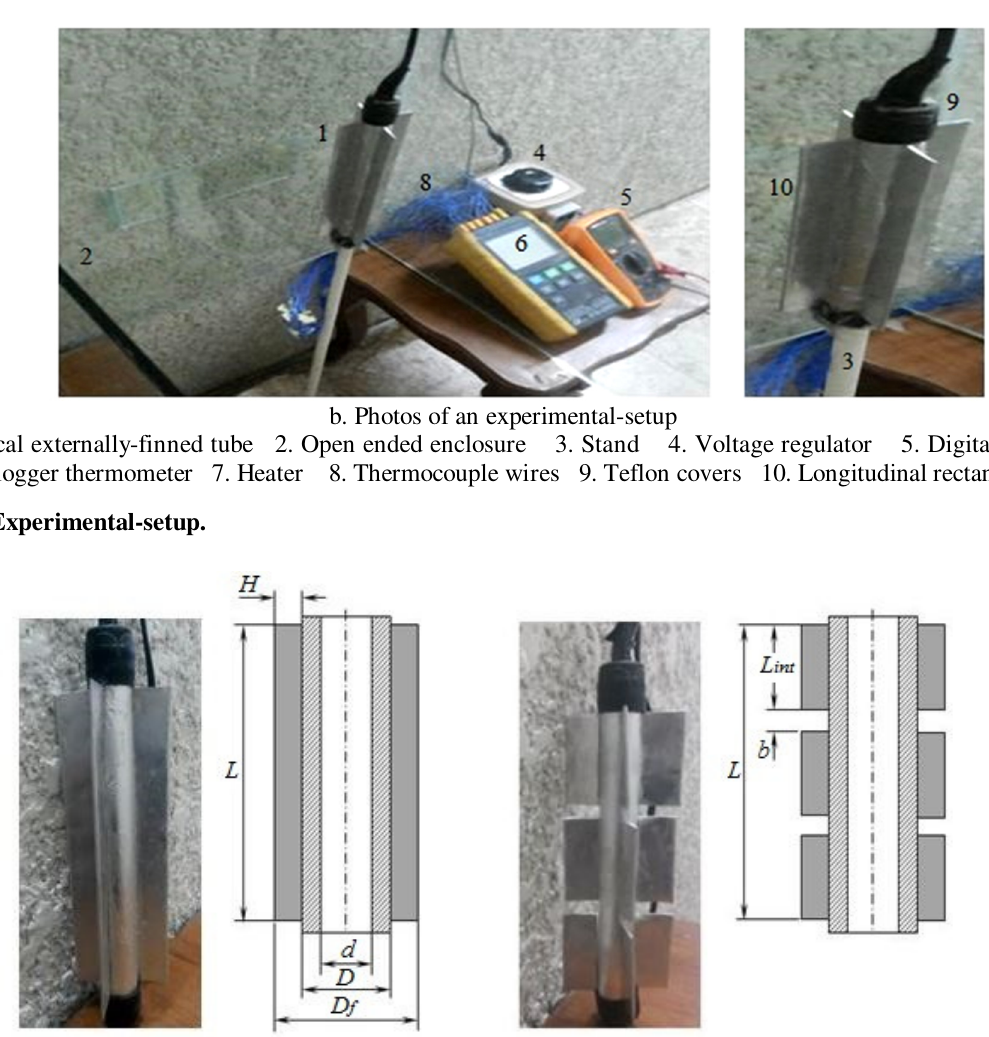
Fig. 2. Front views of longitudinal rectangular fins